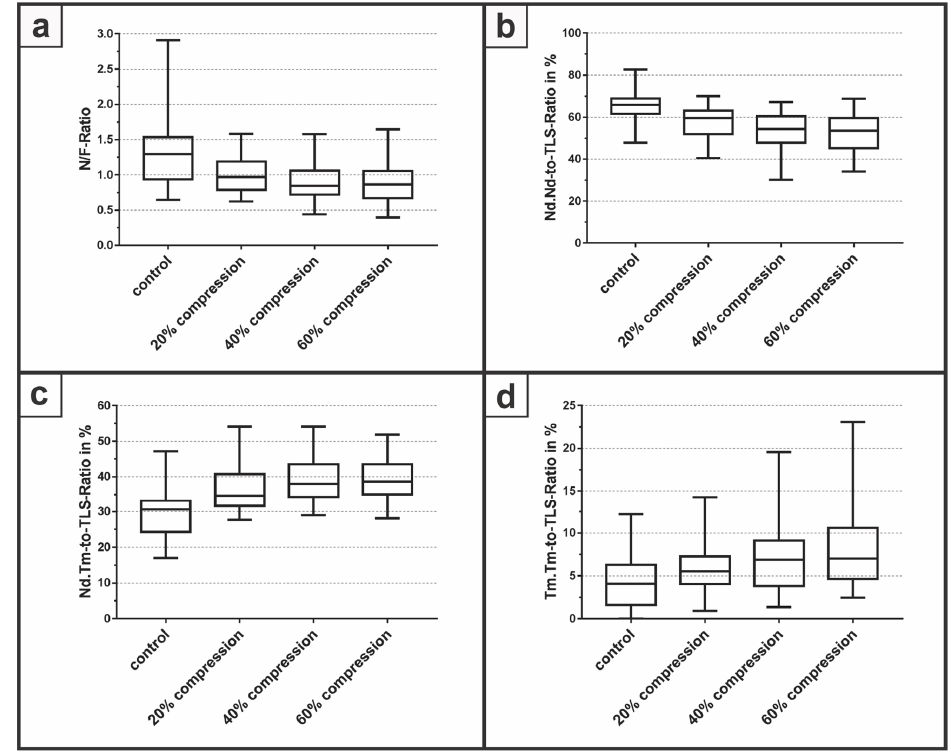
Figure 4. The degree of network connectivity was analyzed with ( a ) the N/F-Ratio followed by a strut analysis via ( b ) Nd.Nd-to-TLS-Ratio; ( c ) Nd.Tm-to-TLS-Ratio; and ( d ) Tm.Tm-to-TLS-Ratio.